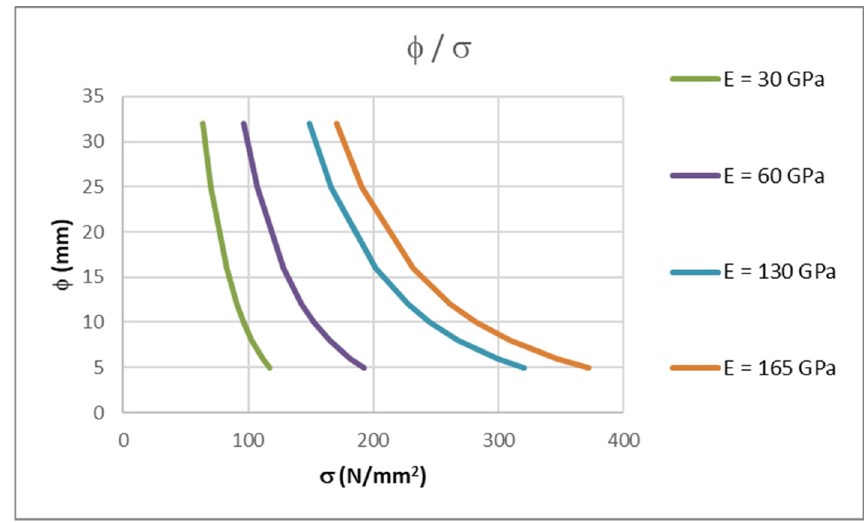
Figure 2. Maximum allowable bar diameter to stress in bar ratios for different FRP modulus of elasticity values and for k 1 = 0.8.